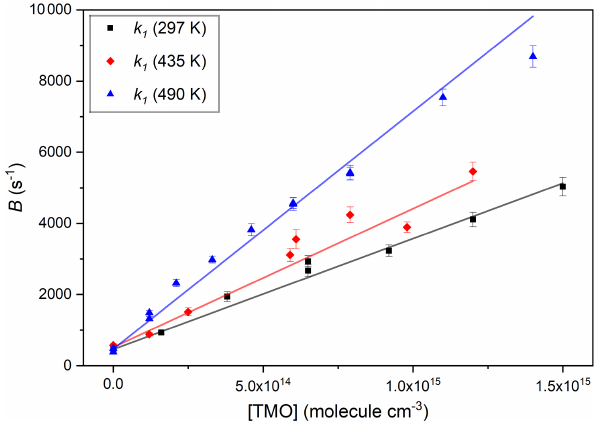
Figure 5. Three typical bimolecular plots of B vs. [TMO] used to obtain k 1 ( T ) for OH + TMO, each fit with Eq. (2) to obtain k 1 (297K) = (3 . 1 ± 0 . 1) × 10 − 12 cm 3 molecule − 1 s − 1 , from the black squares; k 1 (441K) = (3 . 6 ± 0 . 3) × 10 − 12 cm 3 molecule − 1 s − 1 , from the red diamonds; and k 1 (502K) = (5 . 9 ± 0 . 3) × 10 − 12 cm 3 molecule − 1 s − 1 , from the blue triangles.